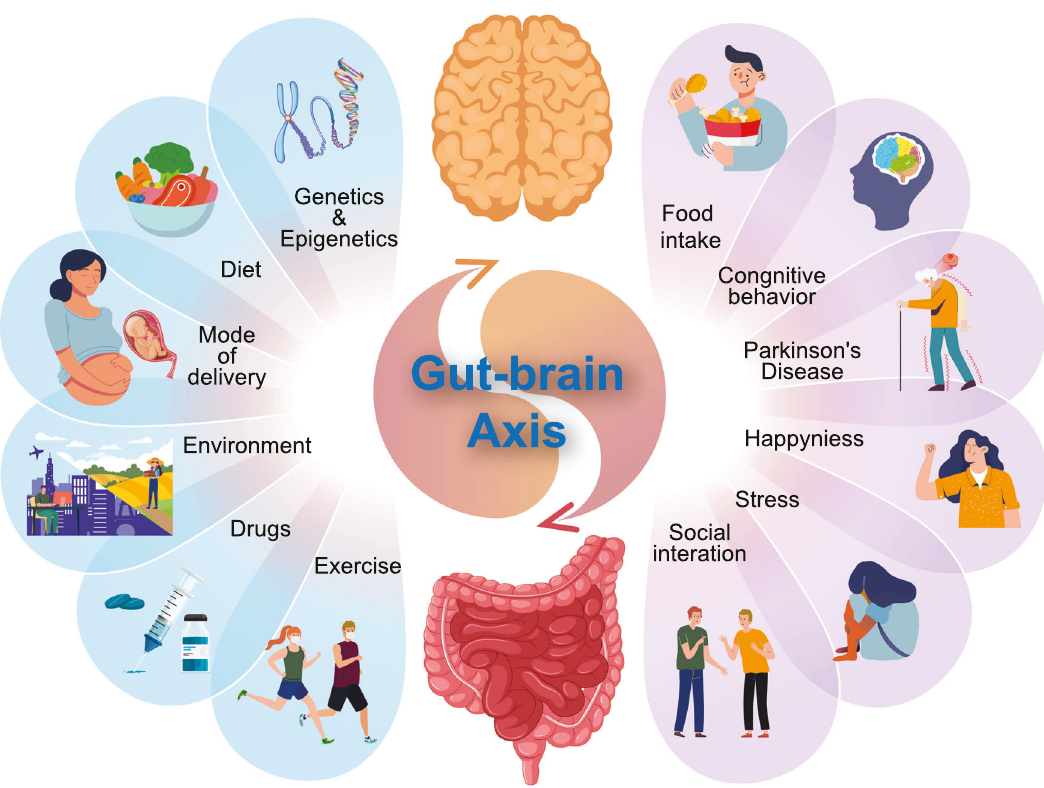
Fig. 2 Bidirectional gut-brain axis interactions and the common factors contributing to the gut – brain